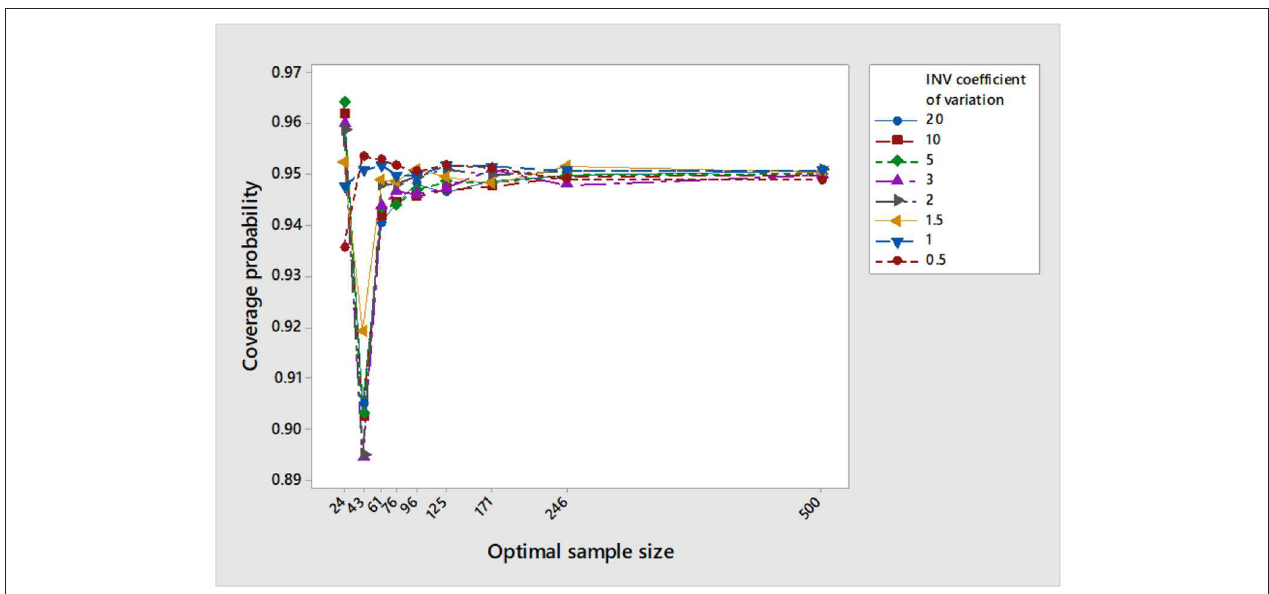
FIGURE 1 | Performance of the simulated coverage probability at µ